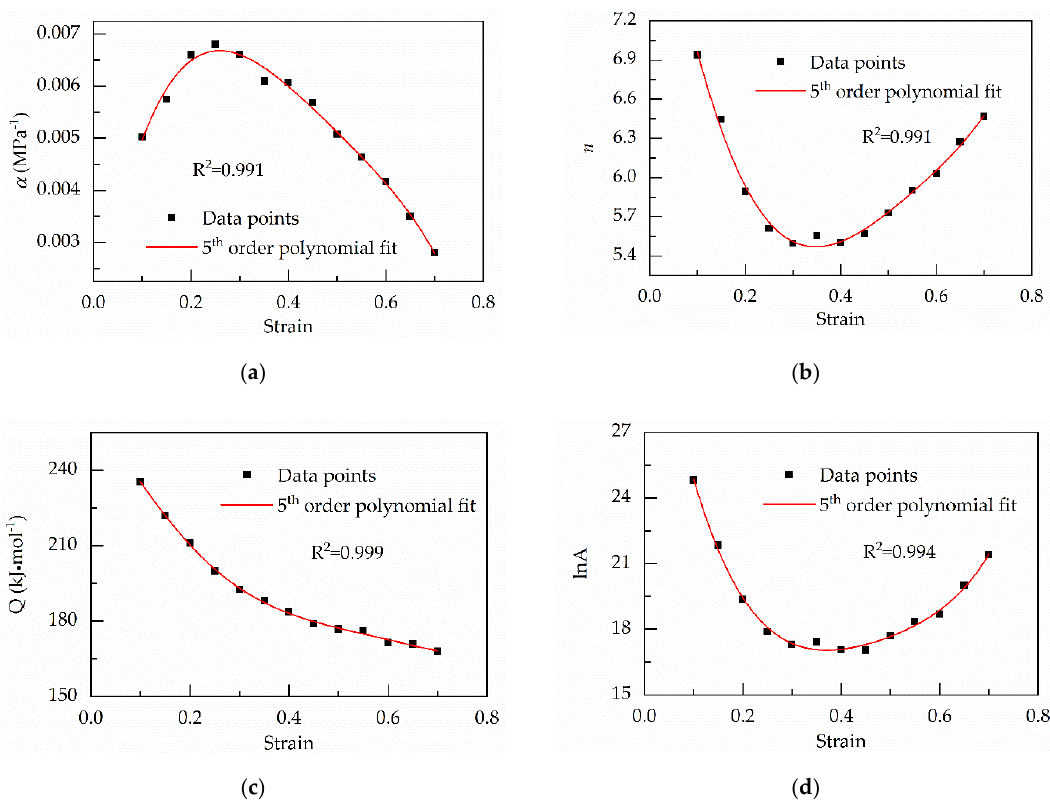
Figure 13. Relationship between the strain and material constants in the msA-type equation. ( a ) α ; ( b ) n ; ( c ) Q; ( d ) A.